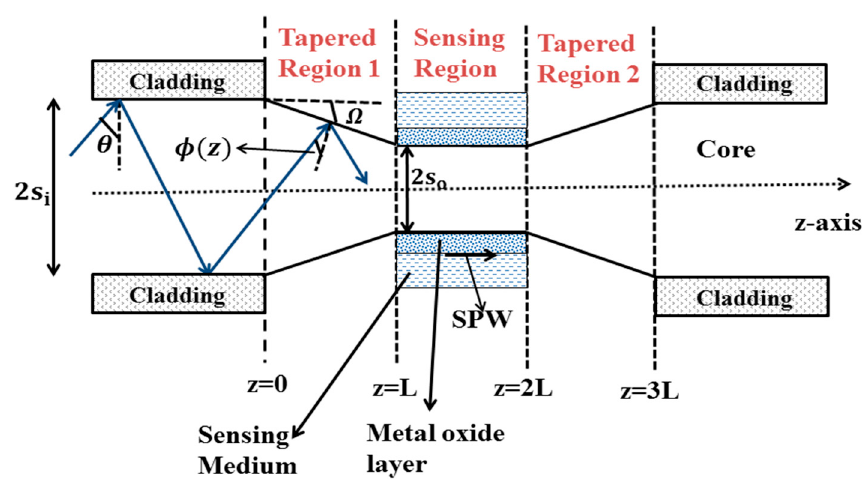
Figure 5. Schematic diagram of proposed LMR-based fiber probe having uniform fiber core placed between two identical tapered regions. Reproduced with permission from [75], copyright IOP Pub- lishing.